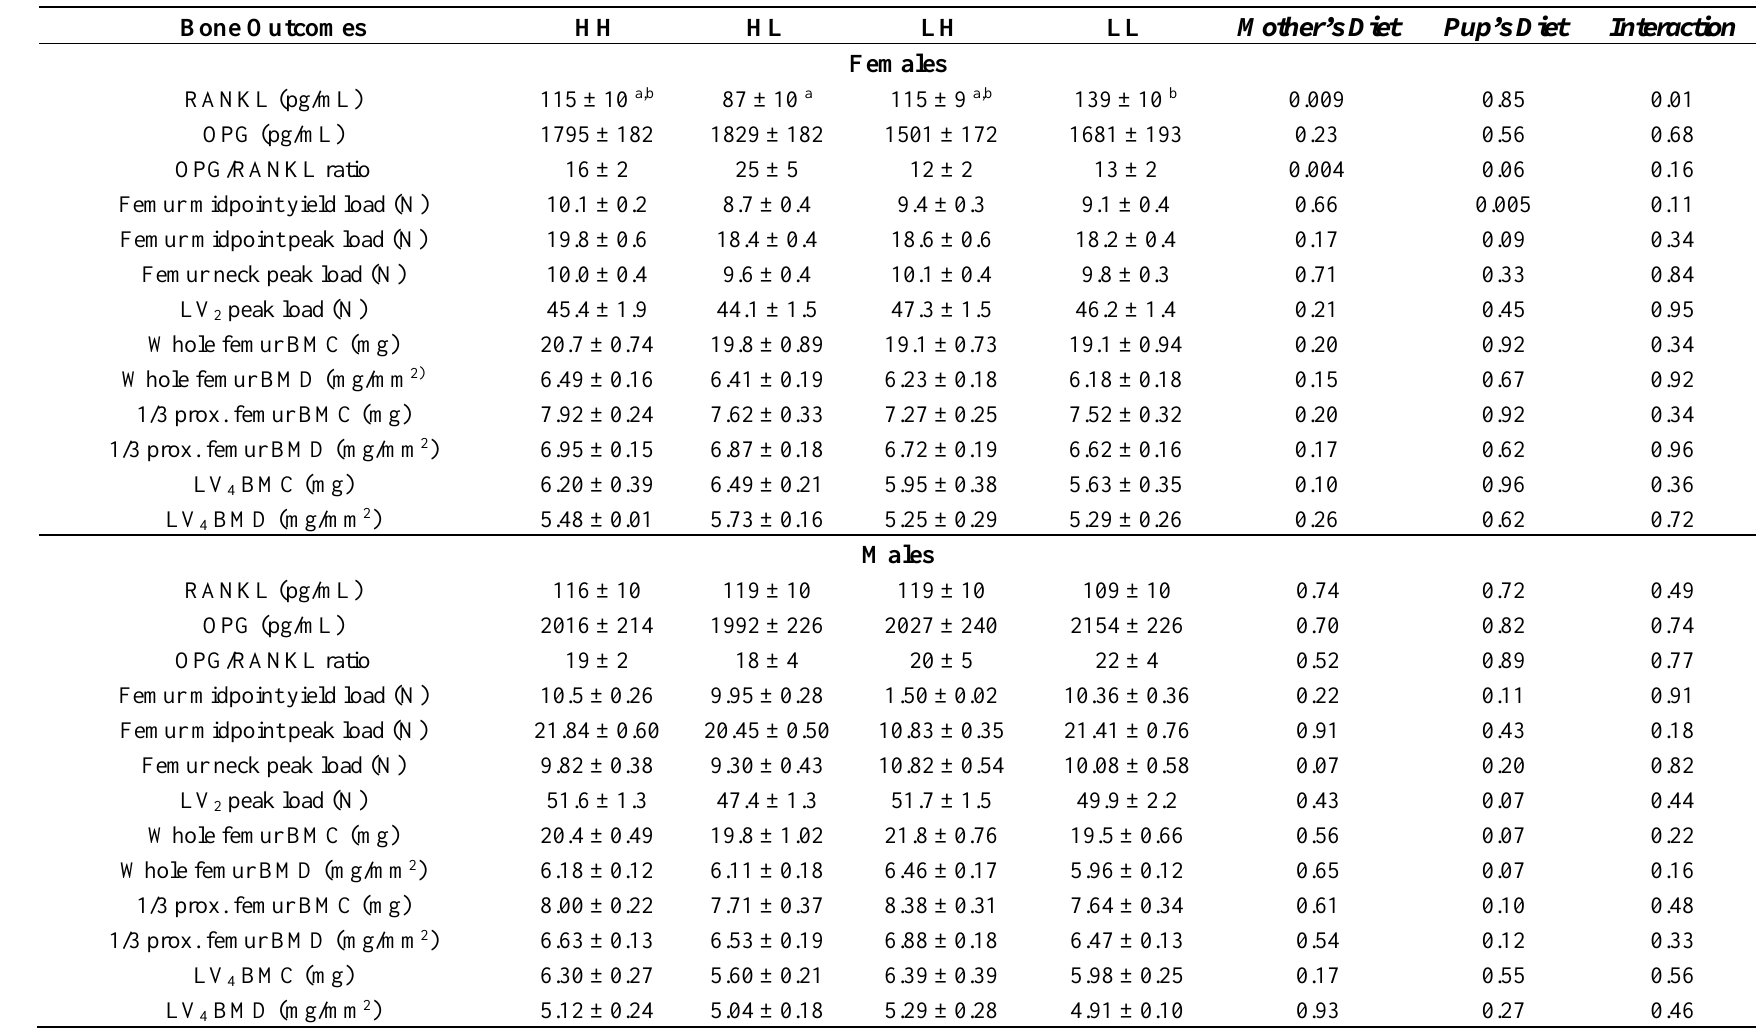
Table 4. Bone outcomes of offspring at three months of age: serum markers, biomechanical bone strength, and bone mineral content and density. Bone Outcomes HH HL LH LL Mother’s Diet Pup’s Diet